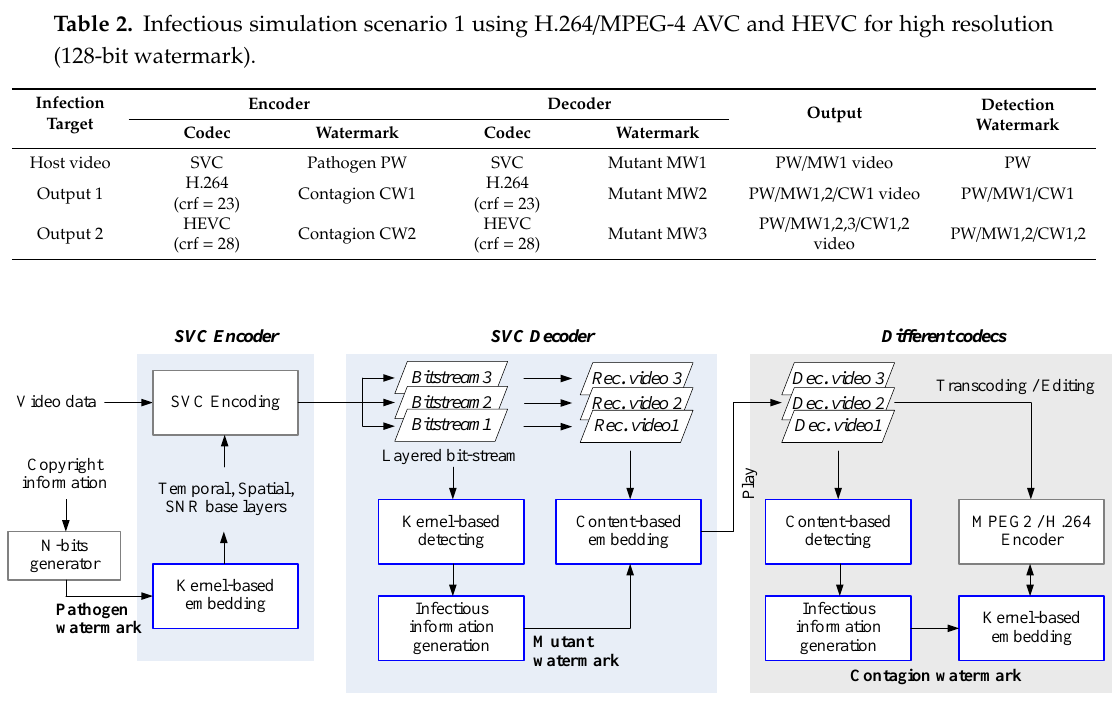
Figure 4. Simulation scenario of our infectious watermarking.